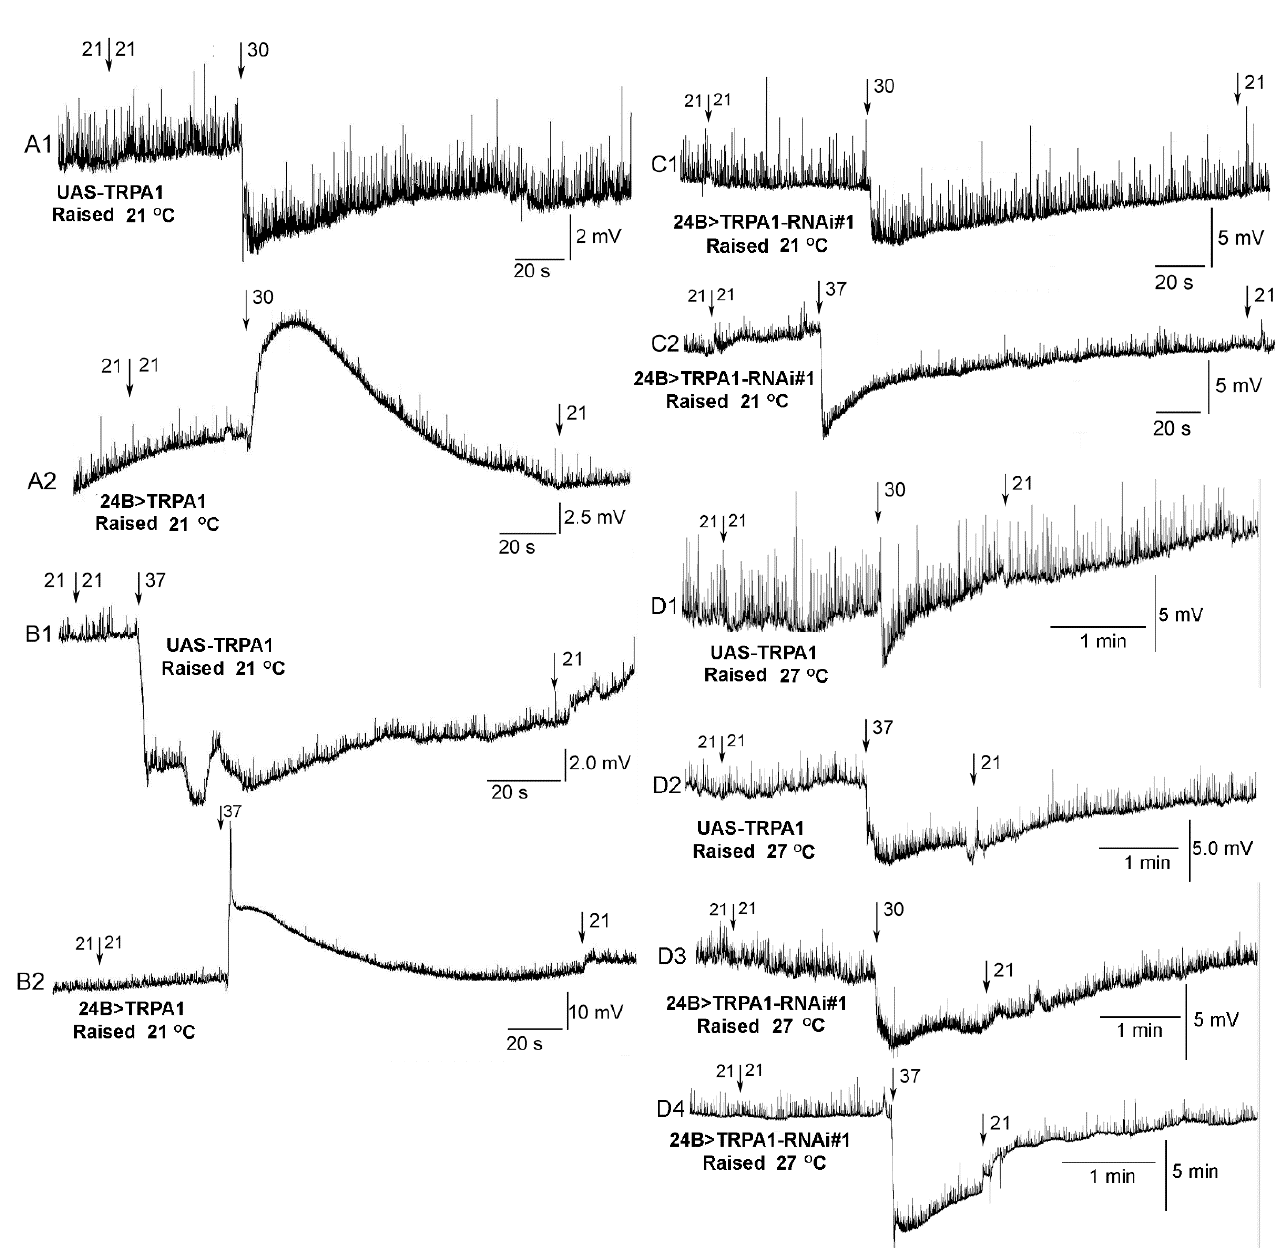
Figure 7. Membrane potential of body wall muscles in TrpA1 overexpressing and RNAi larvae at 30 and 37 °C. The background line of UAS-TrpA1 at 30 °C ( A1 ) and 37 °C ( B1 ) showed hyperpolarization. The 24B>TrpA1 expressing line at 30 °C ( A2 ) and 37 °C ( B2 ) showed transient depolarization. In accordance with the background UAS-TrpA1, the UAS-TrpA1-RNAi#1 at 30 °C ( C1 ) and 37 °C ( C2 ) showed transient hyperpolarization. The lines raised at 21 or 27 °C ( D1 – D4 ) had similar responses. By switching the saline bath from 21 to 21 °C, we controlled for mechanical disturbance of changing the bathing media. Arrows indicate where the saline bath was exchanged. N = 6 for each line for each temperature and the trends were consistent with hyperpolarization (UAS-TRPA as well as UAS-TrpA1-RNAi#1, Sign test, p < 0.05) or depolarization (24B>TrpA1, p < 0.05, Sign test).